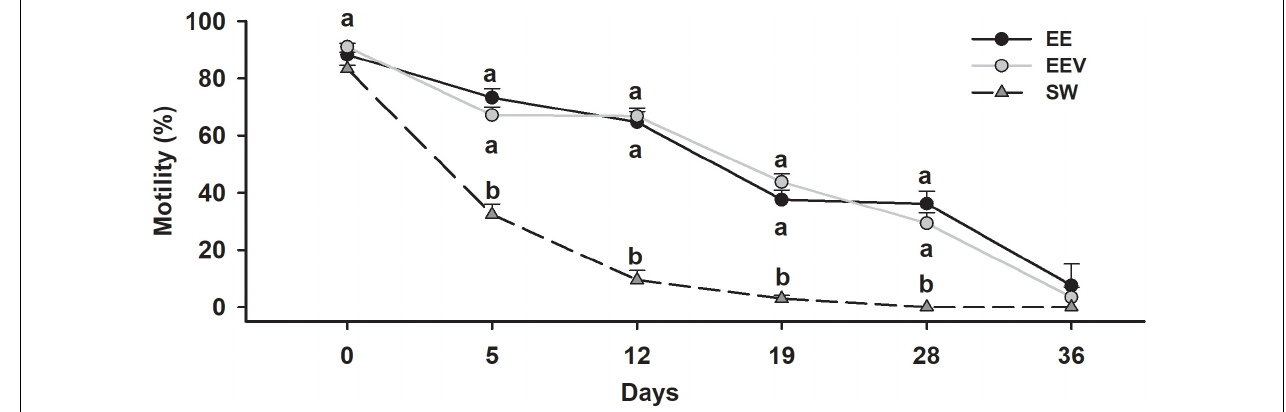
FIGURE 3 | Short-term preservation. Motility variation over time in short-term preservation trials. Scyliorhinus canicula sperm was diluted 1:9 (sperm: dilution medium) with artificial elasmobranch seminal plasma extender (EE), artificial seminal plasma extender variant (EEV), or seawater (SW). Motility was assessed on different days (0, 5, 12, 19, 28, 36) after initial dilution. Lowercase letters represent statistical differences between